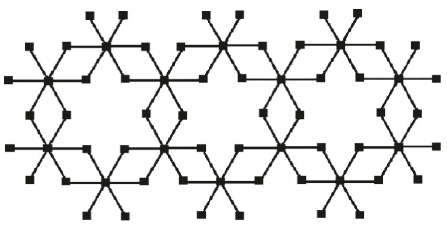
Figure 2: The chain for m � 3 (bismuth triiodide). Table 1: Edge partitioning based on degree of m − BiI